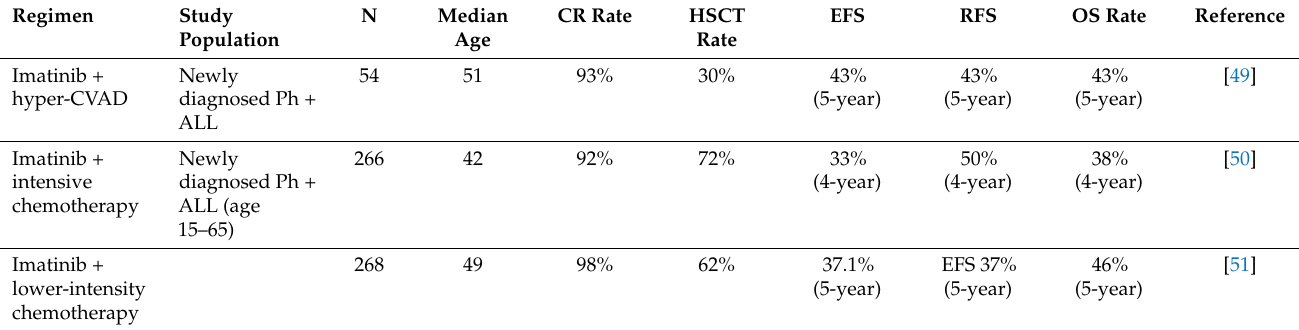
Table 5. Imatinib/chemotherapy combination